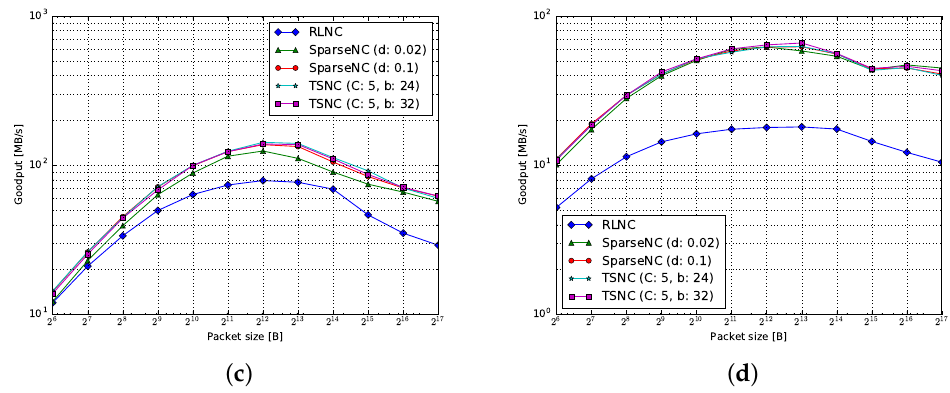
Figure 7. Decoder goodput measurements for the Raspi 2. ( a ) Goodput vs. generation size for q = 2; ( b ) goodput vs. generation size for q = 2 8 ; ( c ) goodput vs. packet size for q = 2, g = 16; ( d ) goodput vs. packet size for q = 2 8 , g = 16.